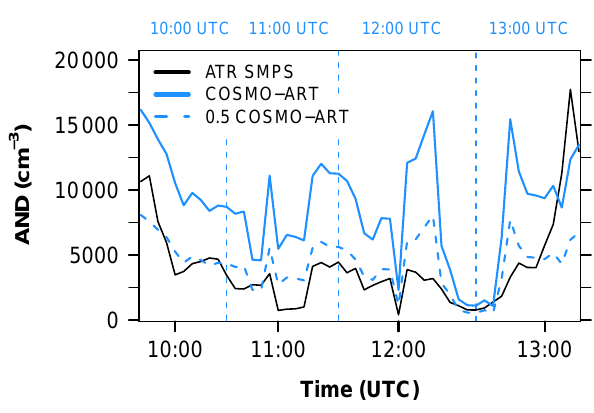
Figure 6. Aerosol number density (AND; cm − 3 ) in the size interval 0.02 to 0.5µm as measured by the spectrometer scanning mobility particle sizer (SMPS) onboard the ATR42 (black) and modeled with COSMO-ART (solid blue, reference case). The horizontal dashed blue line shows the COSMO-ART AND divided by 2. The vertical blue dashed lines indicate the COSMO-ART model output hours, which are compared to